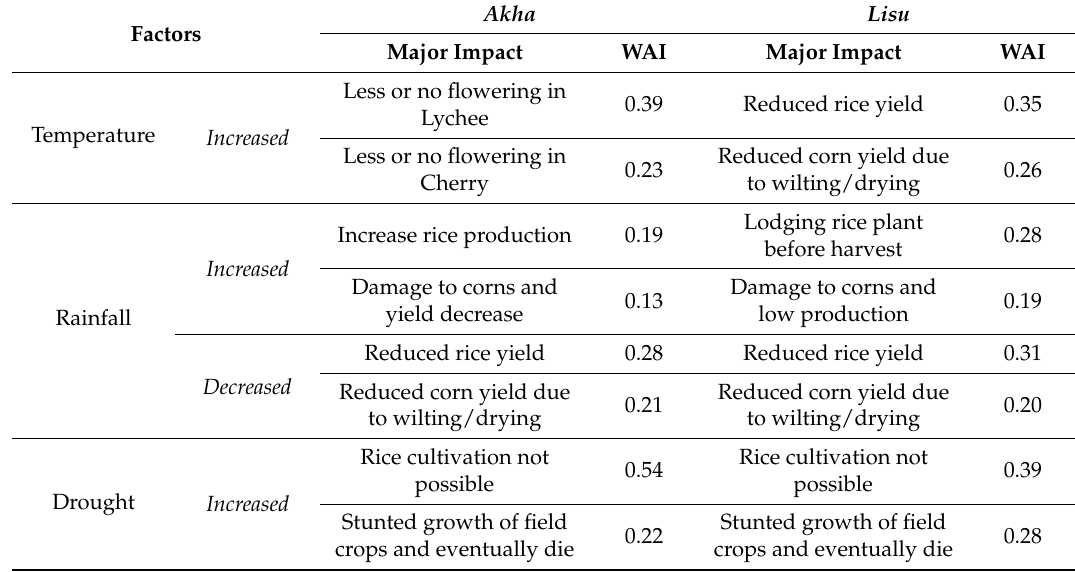
Table 4. Major impacts of climate change on